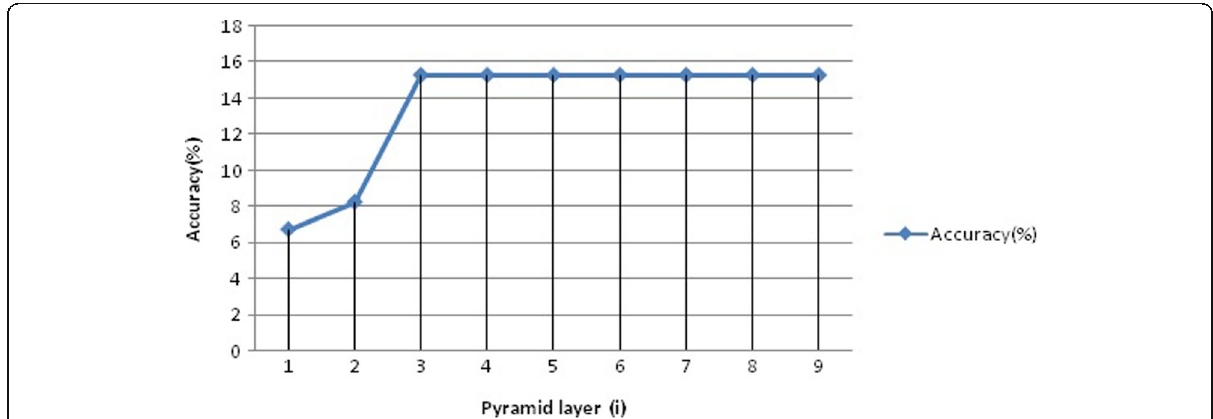
Fig. 23 Diagram of the change of the number of layers of the pyramid and the matching